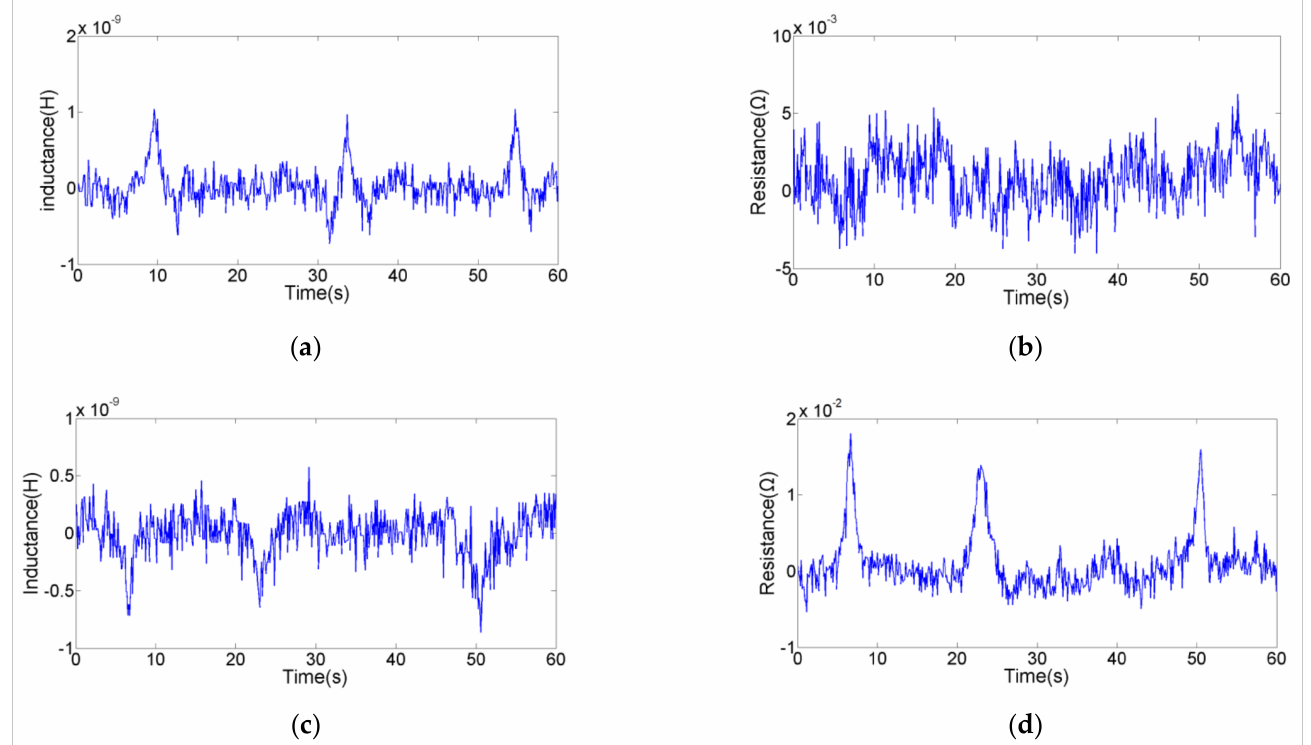
Figure 7. The floor level of inductance detection (with silicon steel strips): ( a ) inductance signal of 46 µ m iron particle; ( b ) resistance signal of 46 µ m iron particle; ( c ) inductance signal of 125 µ m copper particle; ( d ) resistance signal of 125 µ m copper